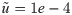
Variation of allele frequency spectra with mutation rate and dispersal kernel.(a) Allele frequency spectra f(x) estimated from 1D simulations with L = 107 and u˜=1e-4. Each curve is the average of frequencies measured from 20 independent simulations. Curves are coloured by dispersal kernel according to the legend in (c). The uptick for the lowest bin is an artifact of the logarithmic bin sizes together with the hard lower cutoff in allele frequency at x = 1/L. Black dotted and dash-dotted lines show the analytical distributions for wavelike spreading and panmictic limits respectively. (b) Same as in (a) except with u˜=1e-6. (c) Frequency spectra from (a) and (b), rescaled to remove the expected variation due to changes in average clone size. Inset, dependence of the cut-off frequency xc on the exponent p when frequency spectra are approximated by a power law f(x) ∝ xp for x ≤ xc and f(x) = 0 for x > xc. Dots show the cutoff estimated numerically as the value for which the second derivative of the rescaled curves first drops below −4, plotted against the observed exponents p ≈ {−0.9, −0.72, −0.47, 0, 1} for the small-frequency behaviour.